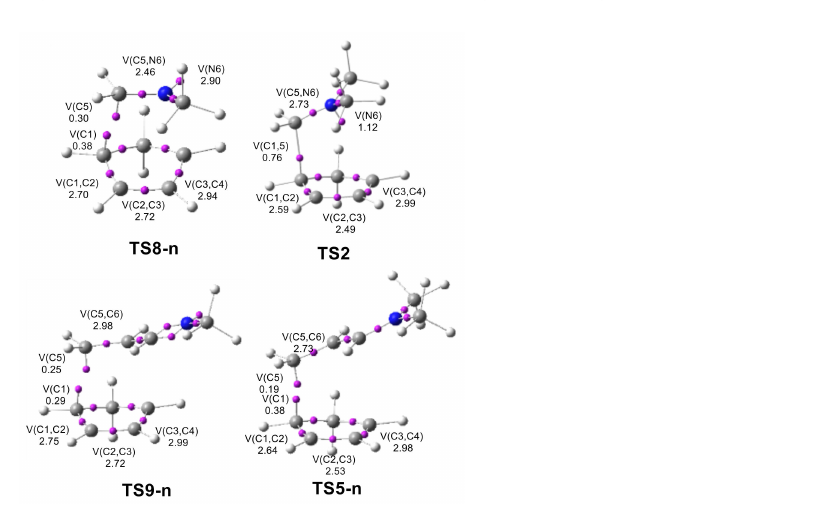
Figure 9. ELF basin attractor positions with the most significant valence basin populations of the TSs involved in the P-DA reaction of Cp 1 with imine 13 , TS8-n , unsaturated imine 14 , TS9-n , and those involved in the I-DA reaction of Cp 1 with iminium cation 6 , TS2 , and unsaturated iminium cation 18 , TS5-n